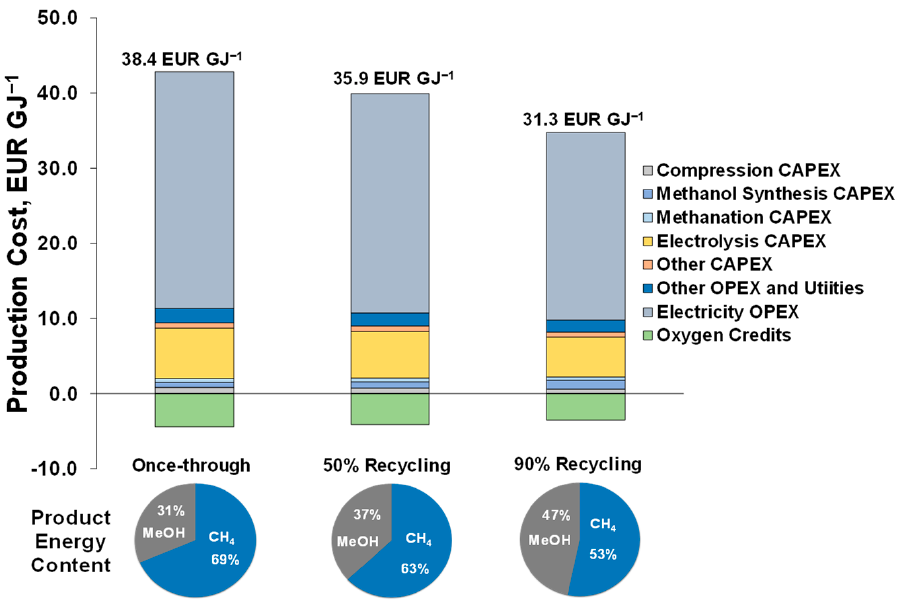
Figure 17. Effect of recycling on total production costs of the combined case.